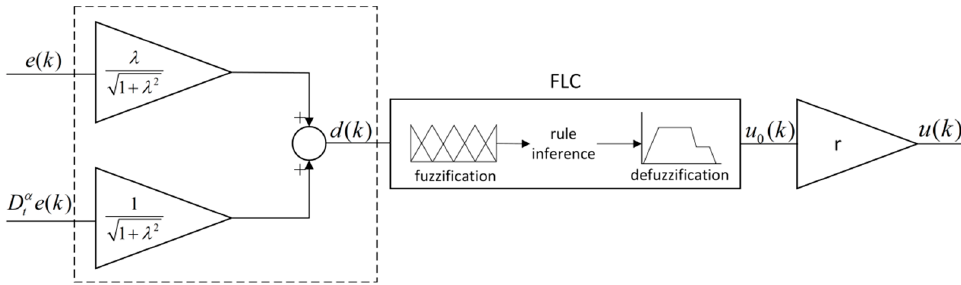
Figure 4. The SIFLC control structure.